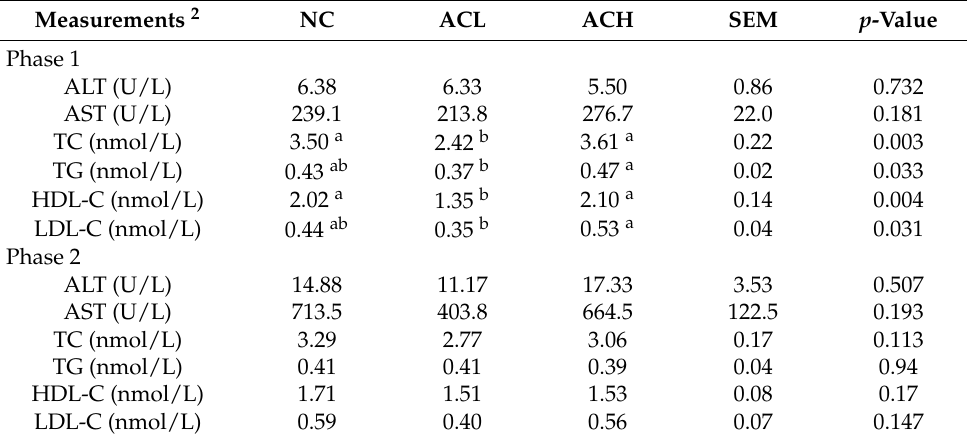
Table 7. Effect of different levels of aging corn on blood lipid and liver enzymes of broilers fed three different experimental diets 1